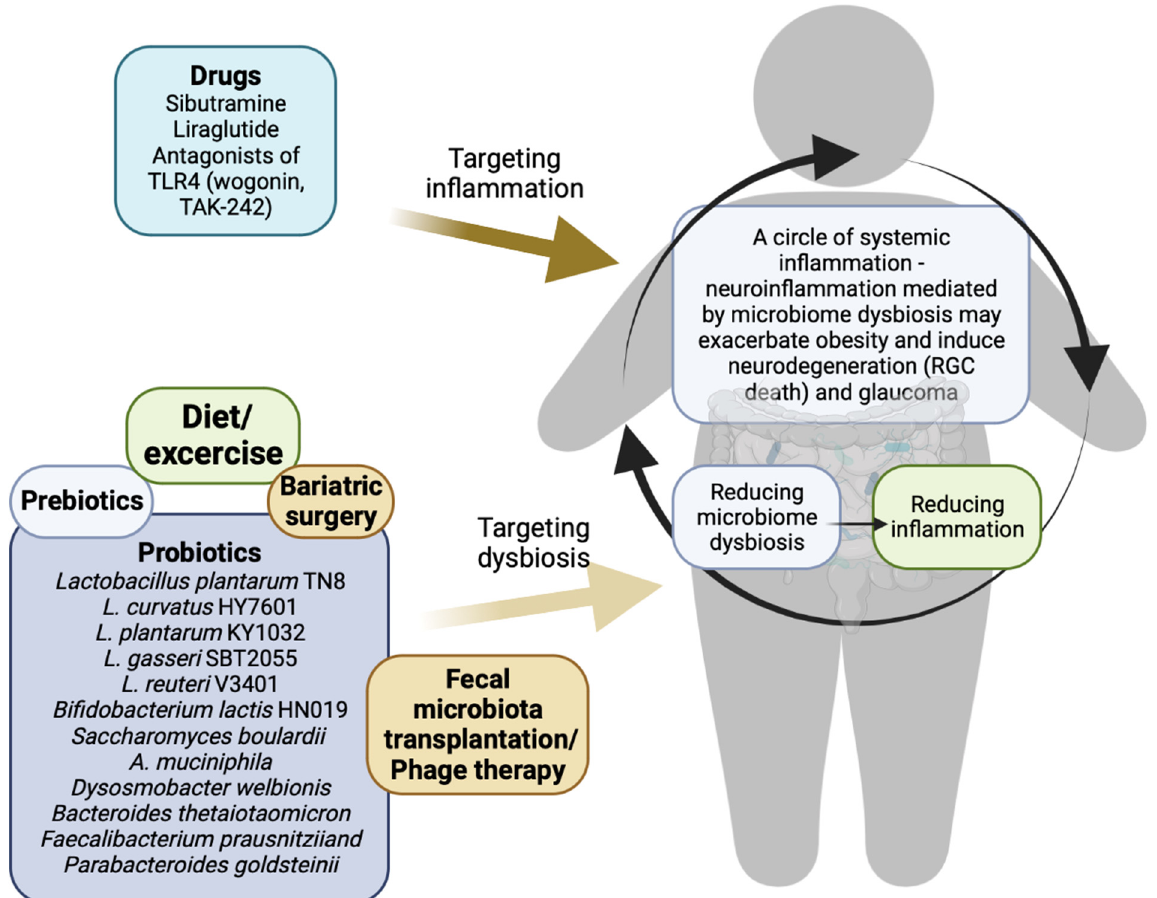
Figure 3. Potential therapies for obesity and glaucoma. Obesity is correlated with gut dysbiosis, and obese individuals have a high risk of developing elevated IOP and glaucoma. Gut dysbiosis could induce systemic inflammation, which is involved in the progression of obesity pathogenesis and various diseases affecting the eye. Promising preventive or therapeutic approaches for both obesity and glaucoma could involve rebalancing microbiome dysbiosis, which is one of the triggers of inflammation in both diseases or directly intervening with anti-inflammatory drugs. RGC: retinal ganglion cell. Created with BioRender.com (accessed on 23 December 2022).